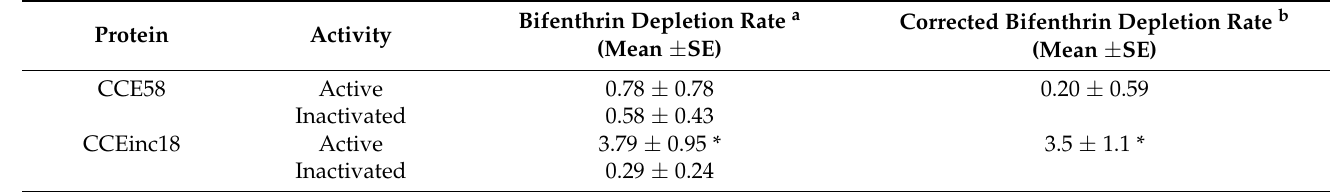
Table 3. Bifenthrin depletion rates of active and inactivated MR-VL CCE58 and